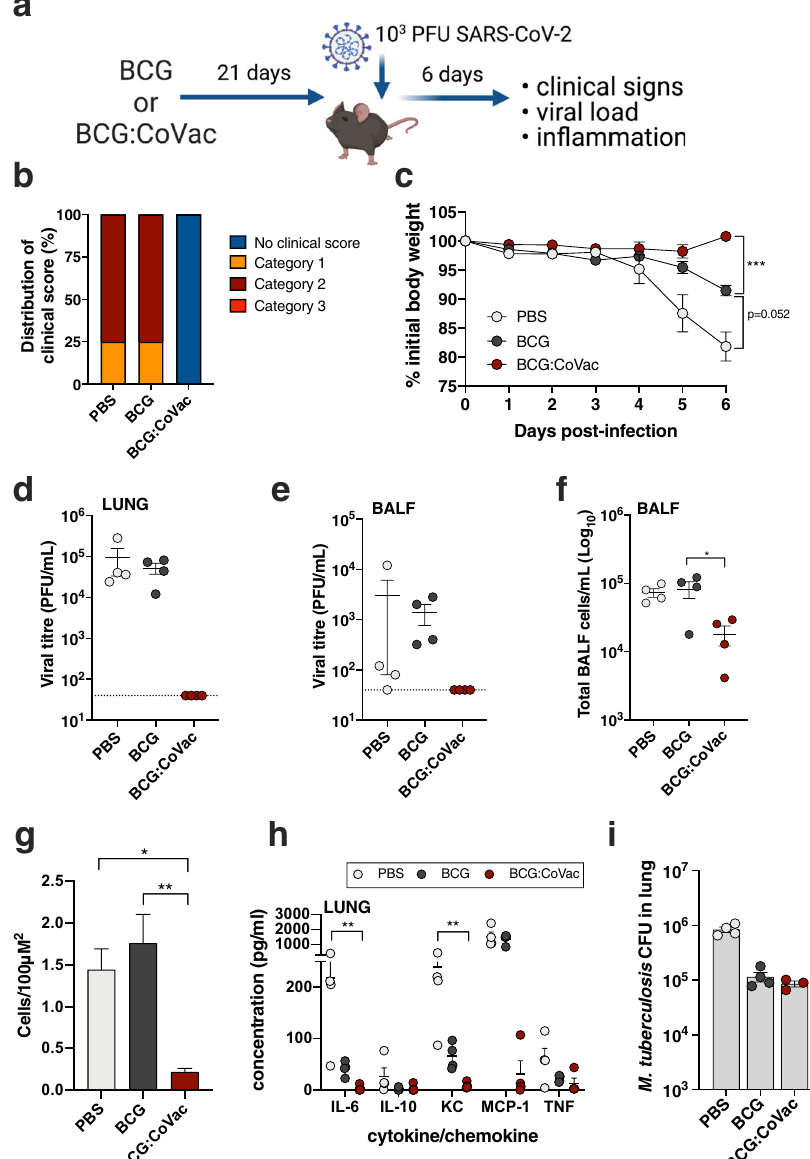
Fig. 4 A single dose of BCG:CoVac protects against severe SARS-CoV-2 infection. a Male K18-hACE2 mice (n = 4/group) were immunised with sham (PBS), BCG or BCG:CoVac 21 days prior to challenge with 10 3 PFU SARS-CoV-2. Disease outcomes were assessed 6 days later. b Clinical scores at day 6 post-infection. c Percentage of initial body weight loss in K18-hACE2 mice. Viral titres in lung homogenates ( d ) or bronchoalveolar lavage fl uid (BALF) ( e ) were determined using plaque assay. The dotted line represents the limit of detection. f Total in fl ammatory cells in bronchoalveolar lavage fl uid (BALF). g Total number of in fl ammatory cells in stained histological sections of lungs. h Cytokine/chemokine quanti fi cation in lung homogenates. i Six weeks after immunisation mice were challenged with M. tuberculosis H37Rv by aerosol (~100 CFU) and four weeks later the bacterial load was assessed in the lungs and presented as log 10 of the mean CFU ± SEM. Signi fi cant differences between groups * p < 0.05, ** p < 0.01 were determined by one-way